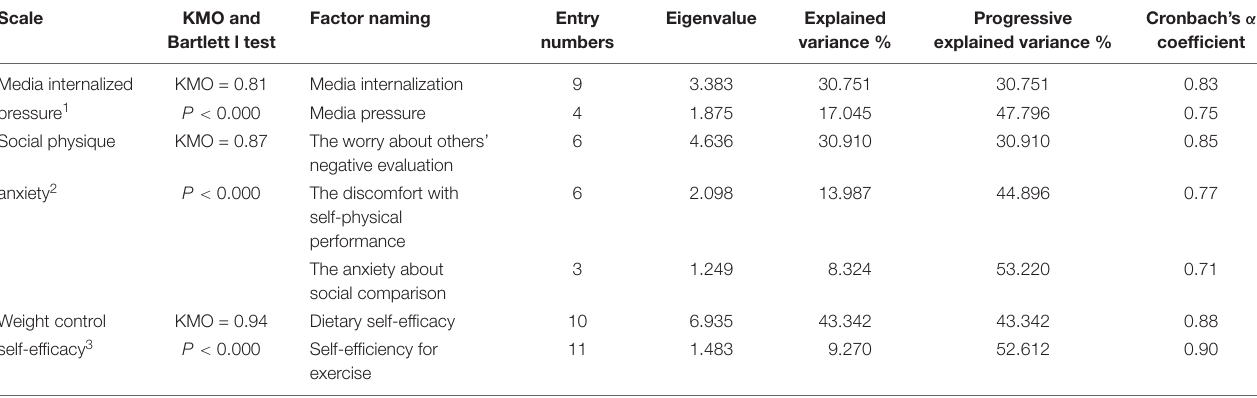
TABLE 2 | Factor extraction and reliability analysis of the three